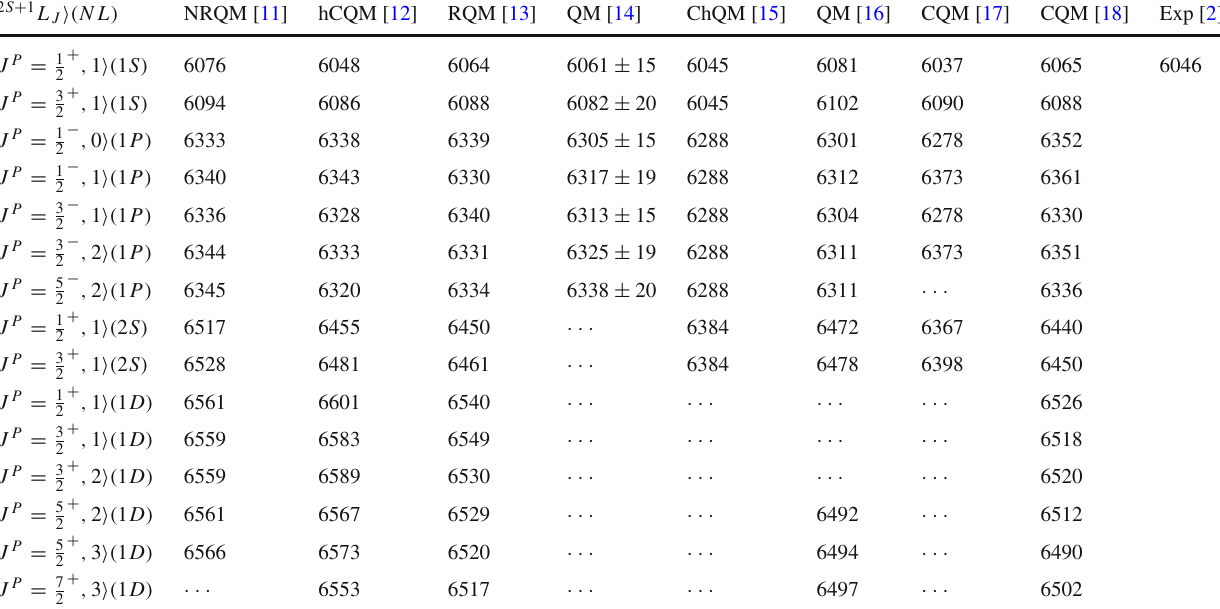
Table 1 The predicted masses (MeV) of the (cid:2) − j - j coupling